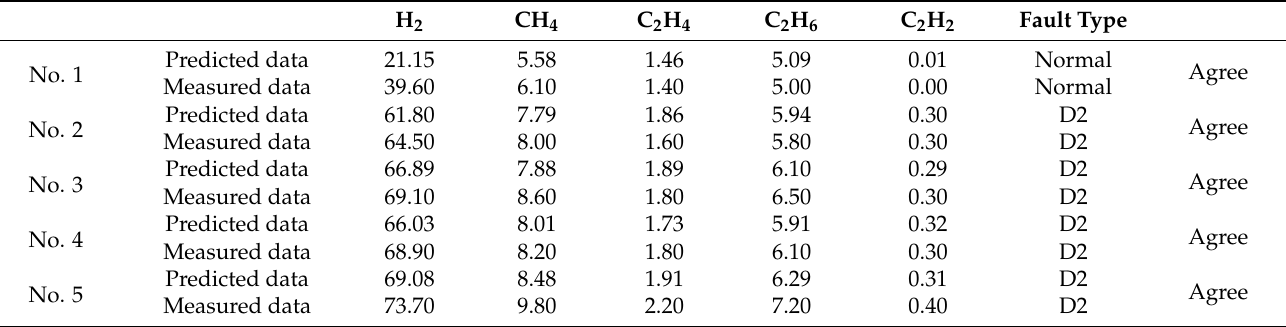
Table 11. Predicted and measured data and corresponding fault